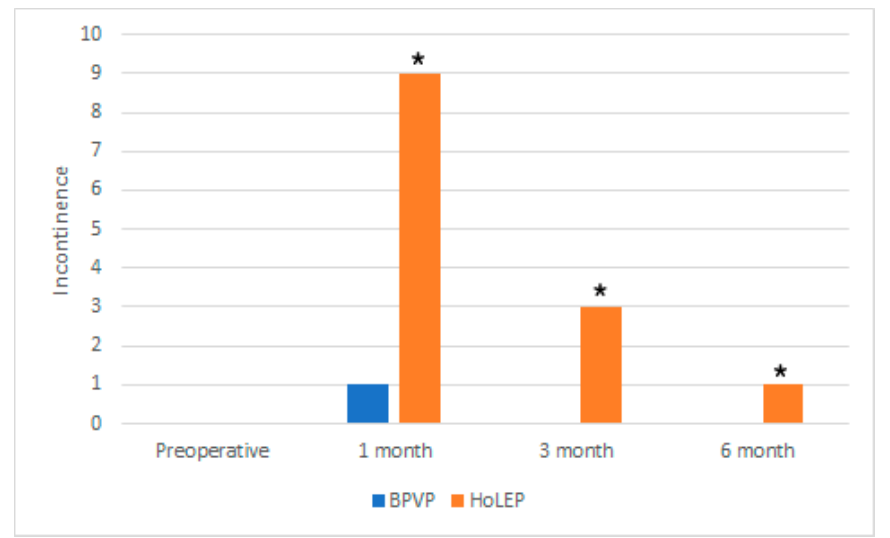
Figure 2. The number of patients reporting incontinence after BPVP and HoLEP for 6 months. BPVP = bipolar plasma vaporization of prostate, HoLEP = holmium laser enucleation of the prostate, * p < 0.05; compared BPVP with HoLEP.